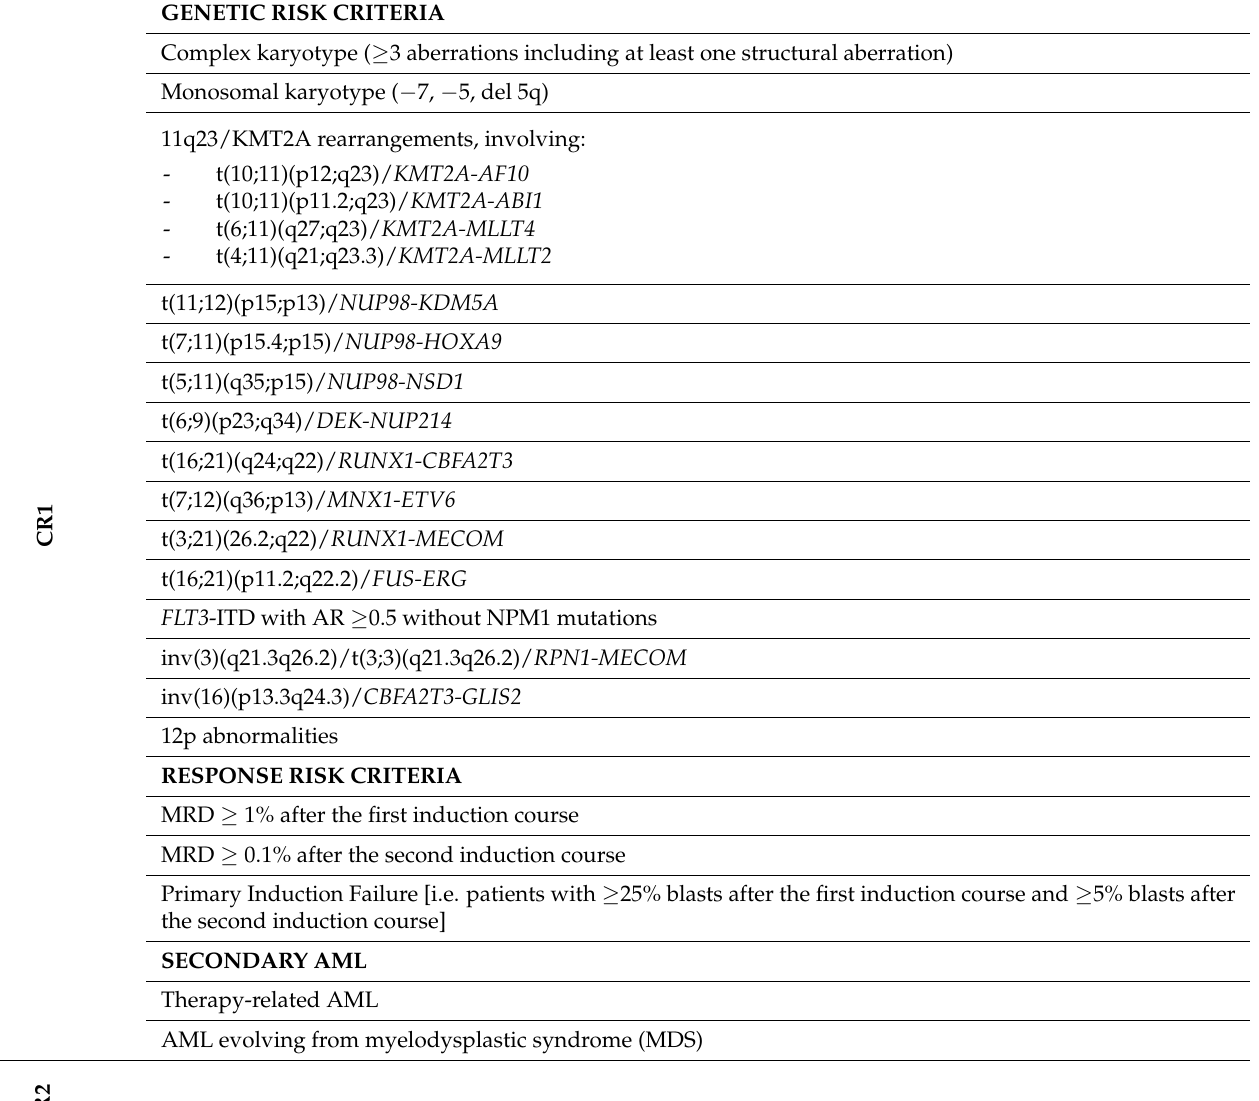
Table 2. HSCT indications in childhood